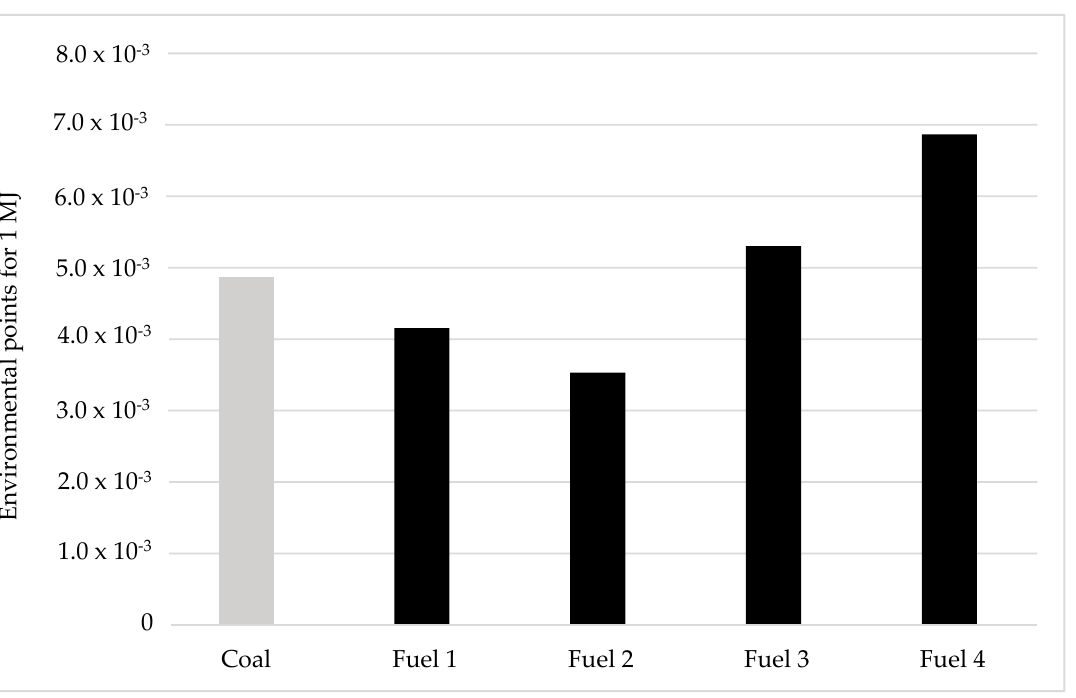
Figure 3. The total burden for people’s health expressed in points for 1 MJ of obtained energy.